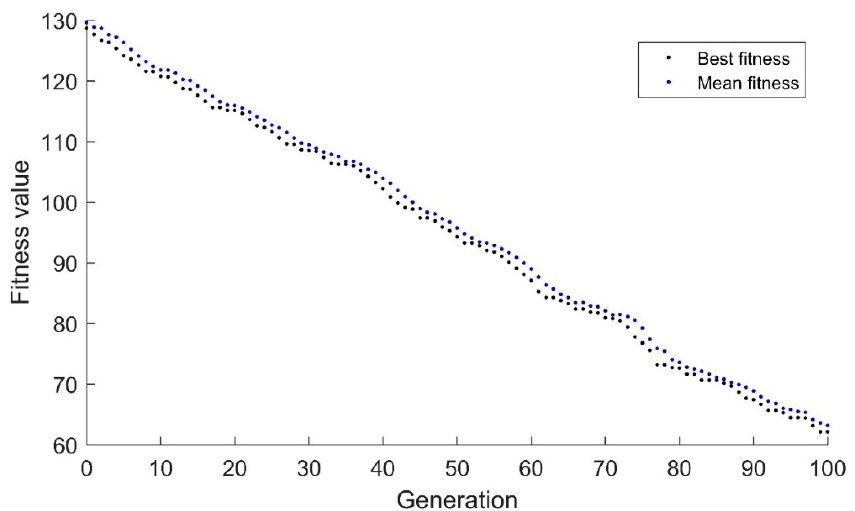
Figure 5. A real-valued genetic algorithm using a normally distributed mutation with standard deviation of 0.01 responding to a sudden jump in the target value after initial convergence.